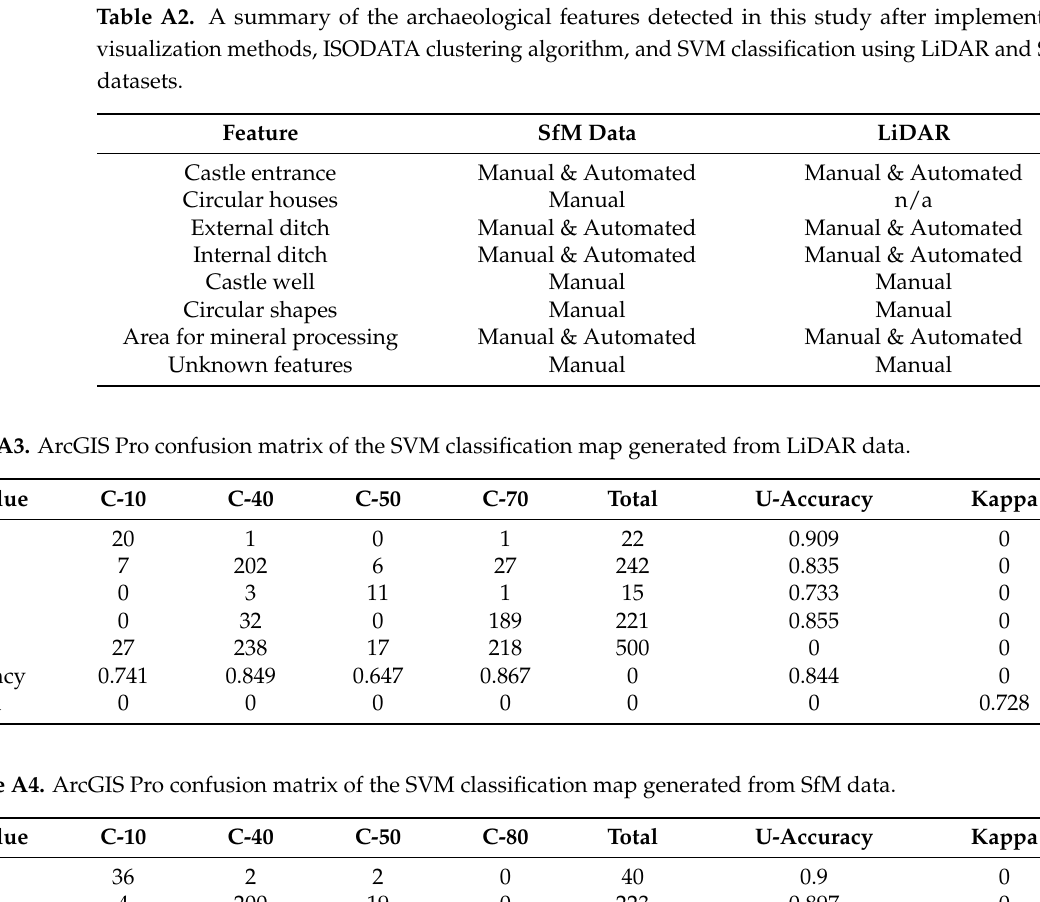
Table A2. A summary of the archaeological features detected in this study after implementing visualization methods, ISODATA clustering algorithm, and SVM classification using LiDAR and SfM datasets.